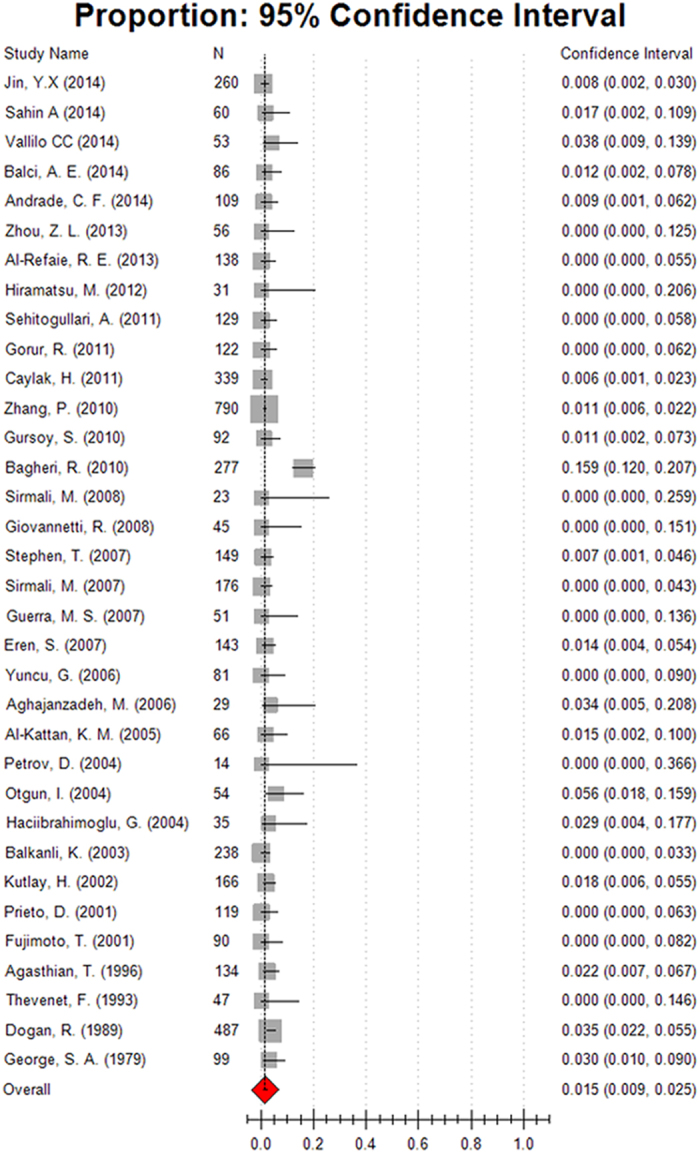
Forest plot assessed mortality of surgery for the treatment of non-CF bronchiectasis.